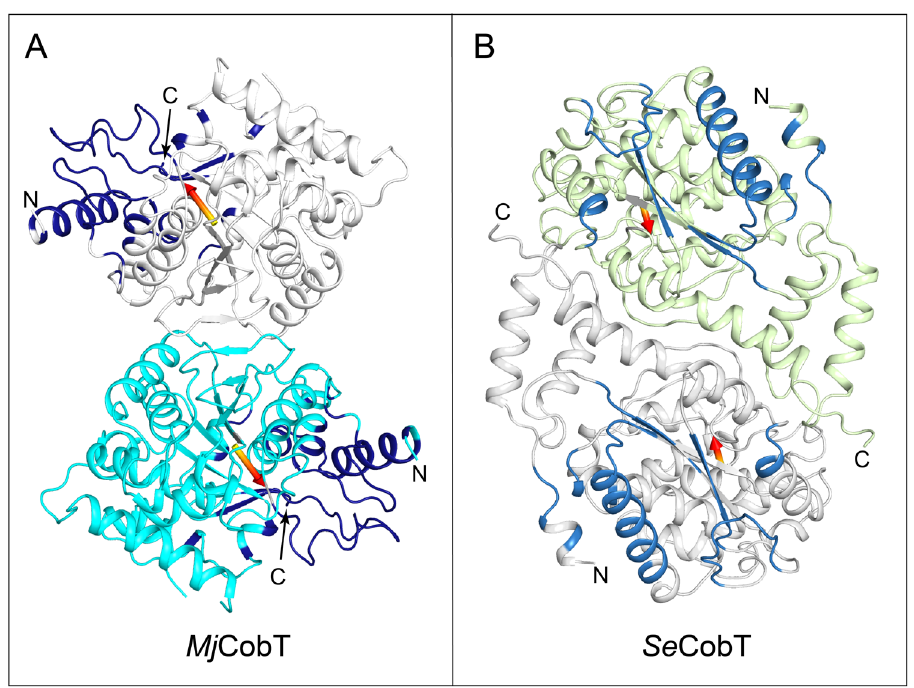
Figure 3. Comparison of the quaternary structures of Mj CobT and Se CobT. The orientation of Mj CobT in its dimer relative to that seen in Se CobT (1L4B) 17 is completely different as indicated by the arrows that depict a similar vector in each monomer. ( A ) shows the quaternary of apo- Mj CobT. The equivalent residues that form the dimer interface in Se CobT are depicted in dark blue. Conversely, the residues in Se CobT that correspond to the interface in Mj CobT are depicted in blue in ( B ). This dramatic difference in assembly follows the rms differences between Mj CobT and Se CobT which are 2.2 Å for 248 equivalent alpha-carbon atoms. This reveals that the enzymes contain a similar fold but differ in their exterior